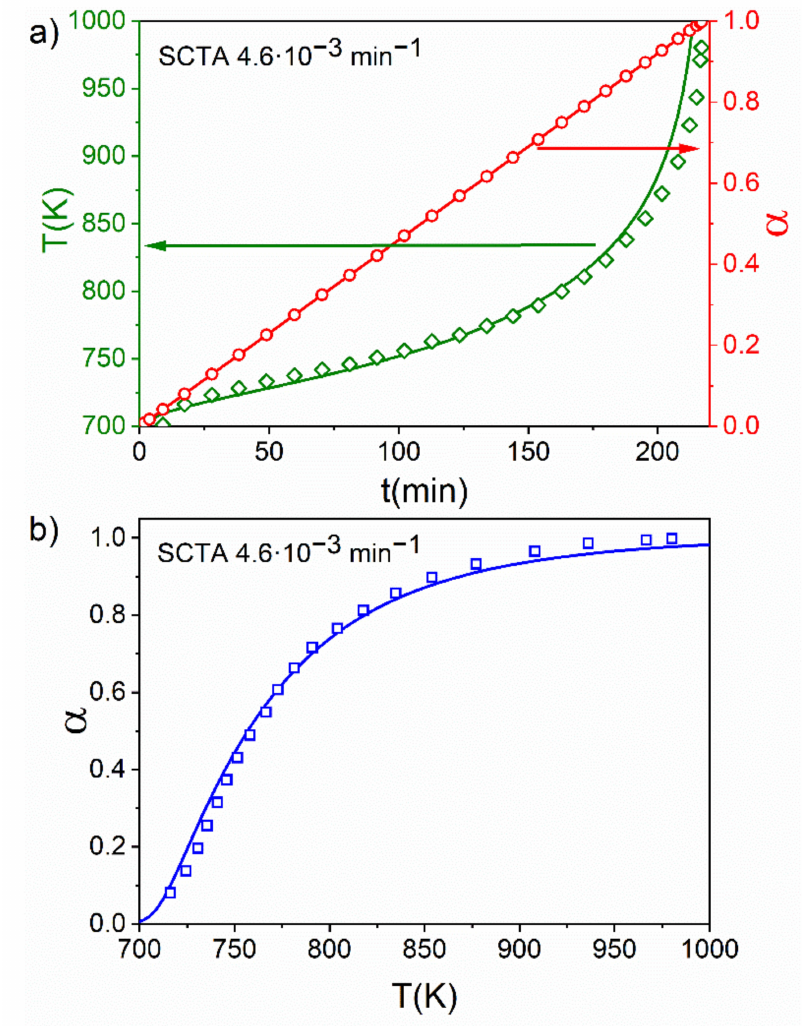
Figure 10. Dehydroxylation of kaolinite conducted under SCTA (4.6 · 10 − 3 min − 1 ). ( a ) Time evolution of the reacted fraction and temperature during reaction. ( b ) Reacted fraction as a function of temperature. Experimental data are depicted as open symbols. Solid lines represent the curves reconstructed using the kinetic parameters resulting from the